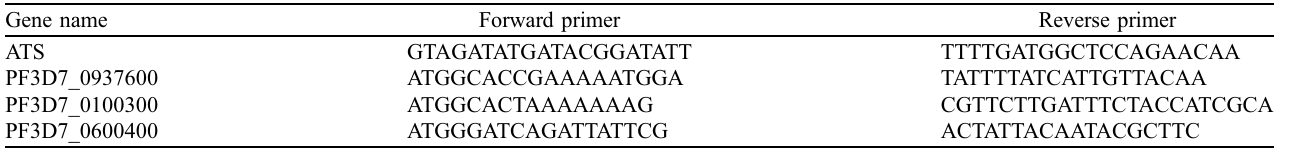
Table 2. The primer sequences for cloning the gene fragments encoding the recombinant proteins expressed in E. coli.